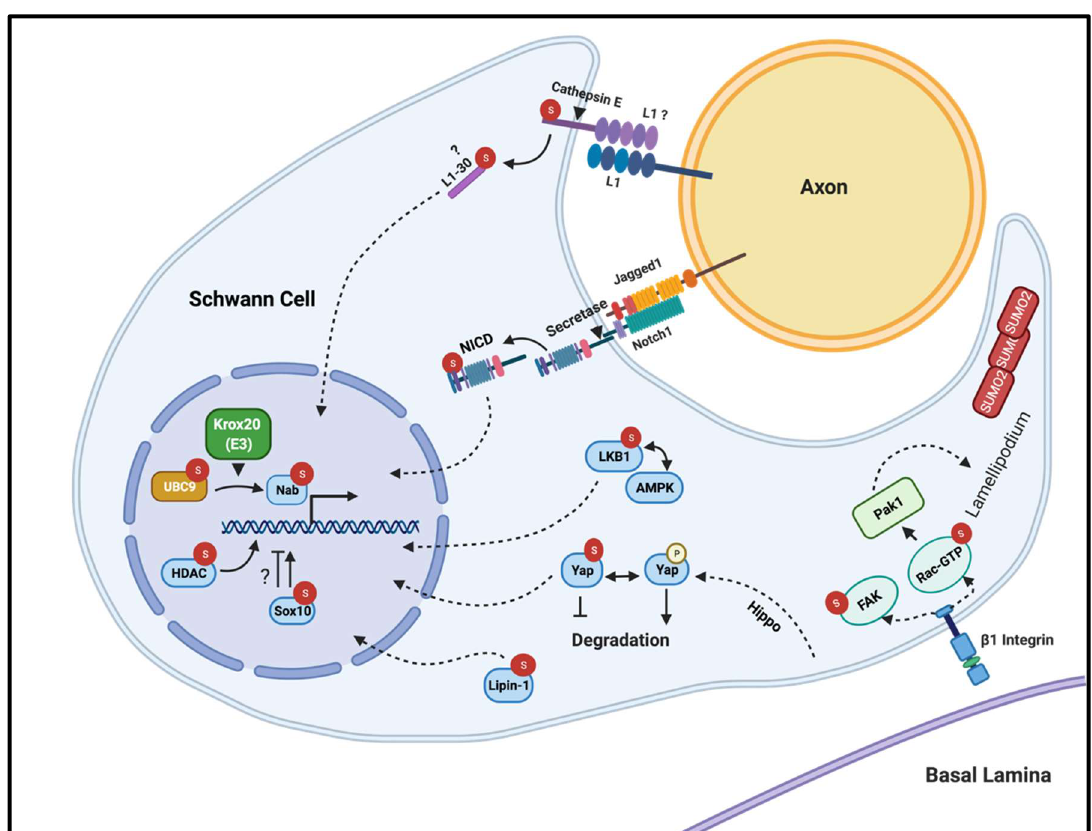
Figure 2. Putative substrates and speculated consequences of their SUMOylation in Schwann cells during PNS development. Sumo2 was found to be enriched in Schwann cell protrusions extending towards neuronal preparations, suggesting that SUMOylation may be involved in axoglial interaction and myelination. Rac1 is necessary for proper radial sorting and myelination by Schwann cells through the formation of radial lamellipodia, and, in MEFs, Rac1 SUMOylation is required for GTP loading/GTPase activity consequently leading to lamellipodia-ruffle formation. SUMOylation may control Schwann cell proliferation and differentiation by stimulating the autophosphorylation and subsequent activation of the